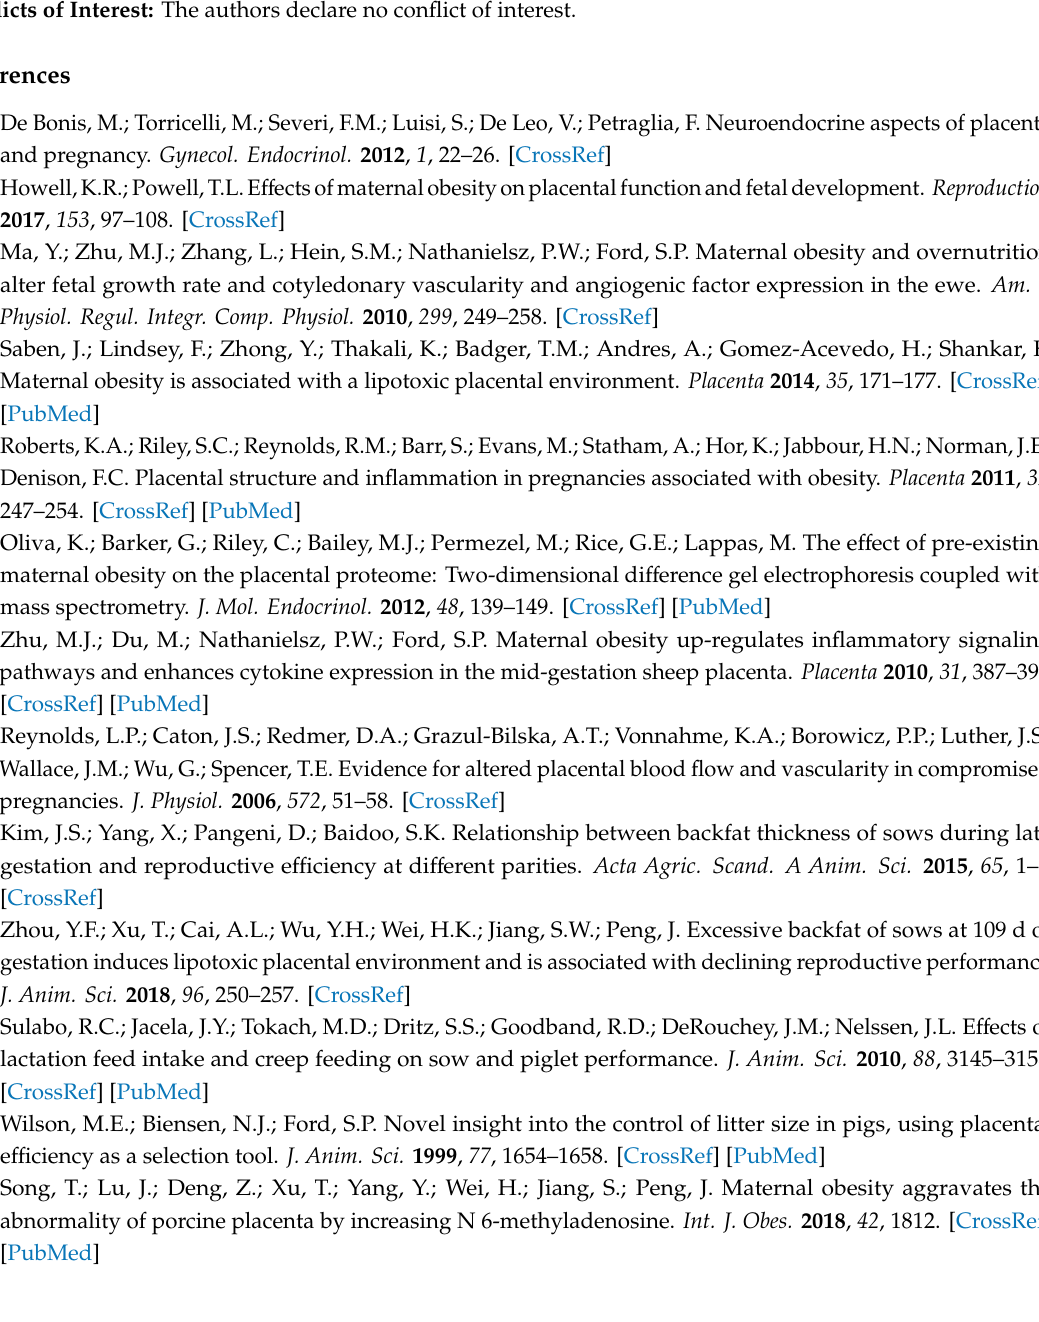
Table S1: Primer sets used for real-time quantitative